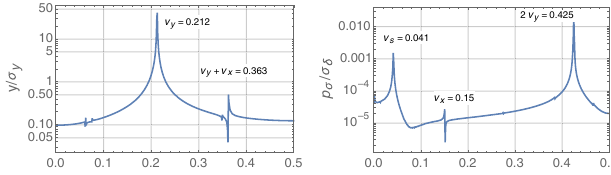
FIG. 11. Spectrum of vertical (left) and longitudinal (right) motion from tracking corresponding to initial condition y ¼ 58 σ , and adjusted longitudinal initial conditions (30) and (31). y